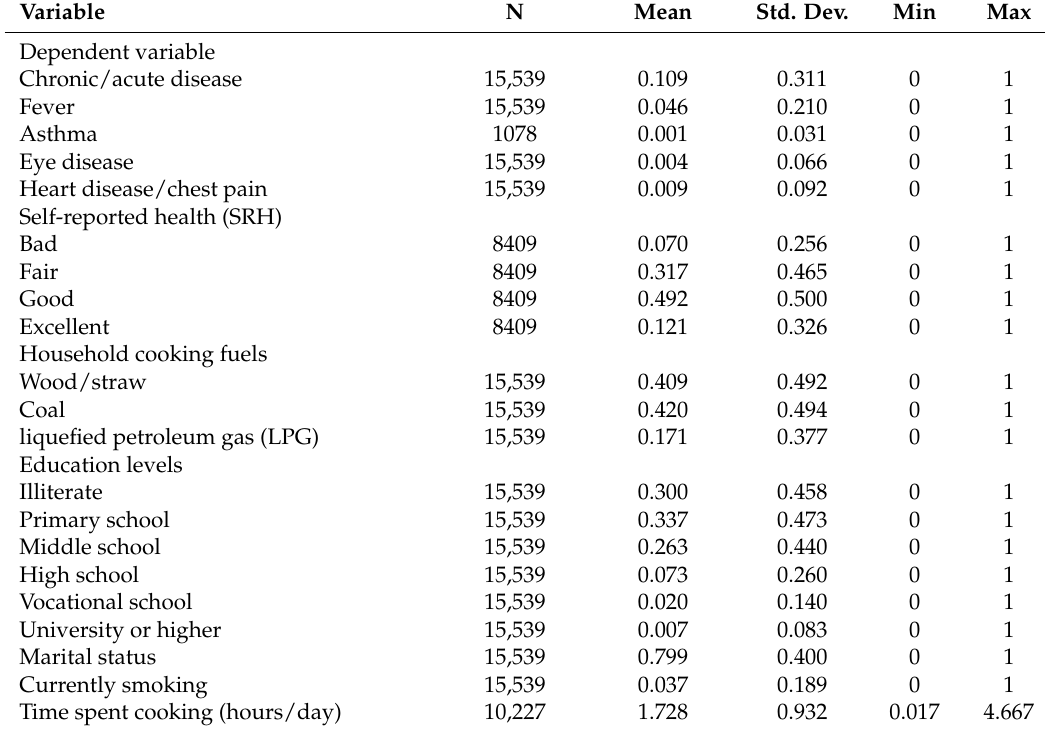
Table 2. Descriptive statistics: CHNS